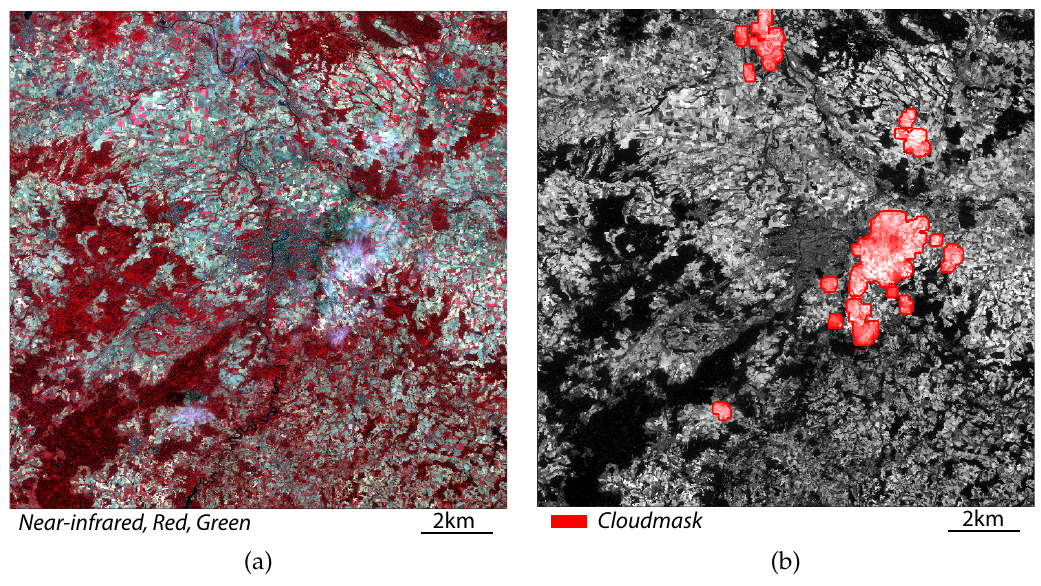
Figure 3. Example of cloud mask detection on a Sentinel-2 image: ( a ) original Sentinel-2 image; ( b ) detected cloud